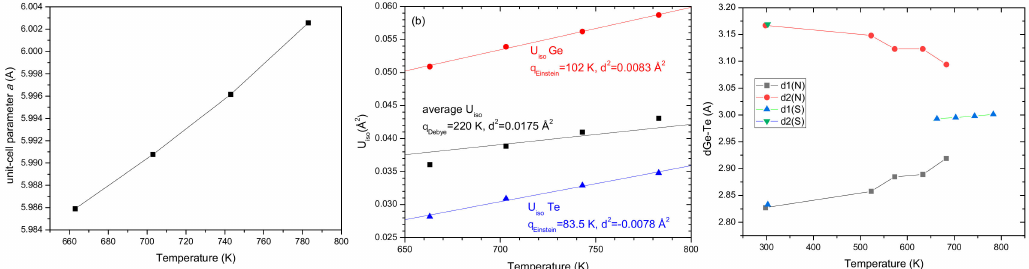
Figure 7. Thermal evolution of ( a ) unit cell parameters of the cubic phase at 663 K and above; ( b ) displacement factors, U iso , for Ge (red circles) and Te (blue triangles) with corresponding Einstein oscillator analysis, and averaged U iso (black squares) with Debye analysis, indicating the best-fit Einstein and Debye temperatures and static disorder parameters; and ( c ) Ge-Te distances, including those obtained below the transition from NPD data, and above from SXRD